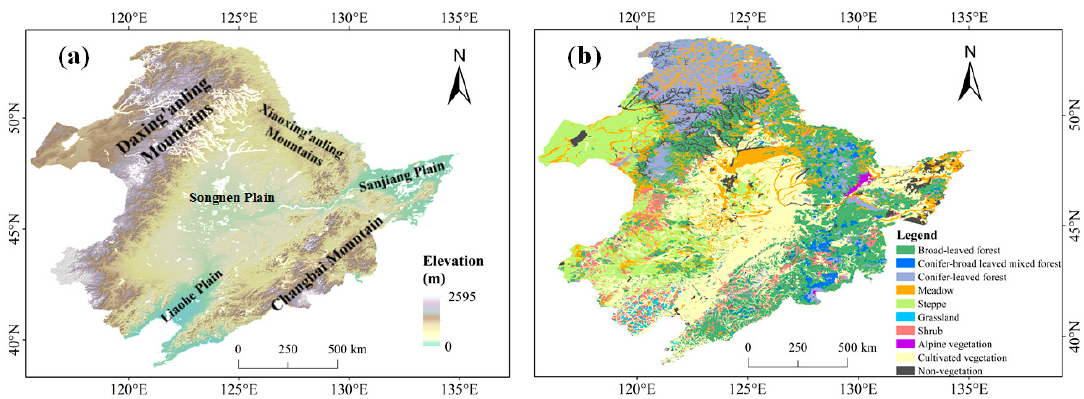
Figure 1. Topographic map ( a ) and vegetation types ( b ) in Northeast China.